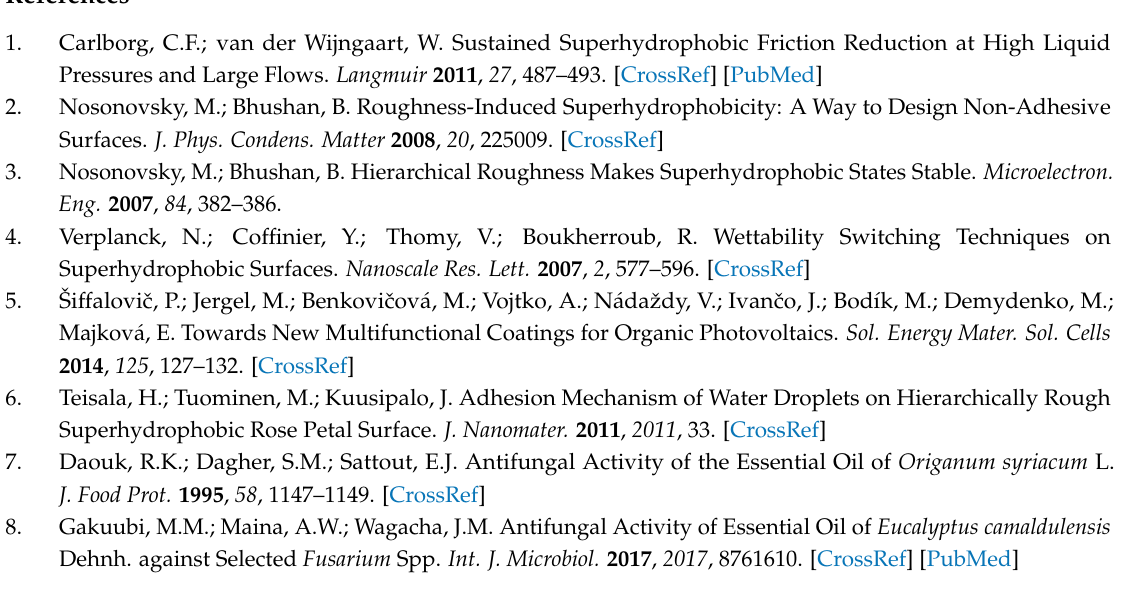
Figure S1: Illustrative images of untreated and treated samples affected by fungal growth. A, O, T mean arborvitae, oregano, and thyme, respectively. Figure S2: Scheme of reflectance measurement in diffuse setting. Figure S3: Disc diffusion assay of Exophiala sp. on petri dishes. Figure S4: Disc diffusion assay of A. fumigatus on petri dishes. Figure S5: The water contact angle measurements of various samples of whitewood, sandstone, and paper substrate. A, O, T mean arborvitae, oregano, and thyme essential oils, respectively. Figure S6: Color changes of whitewood samples after application of SHNPs and 50% thyme EO encoded in CIE L*a*b* color space. The color differences E* ab are given in the upper-right